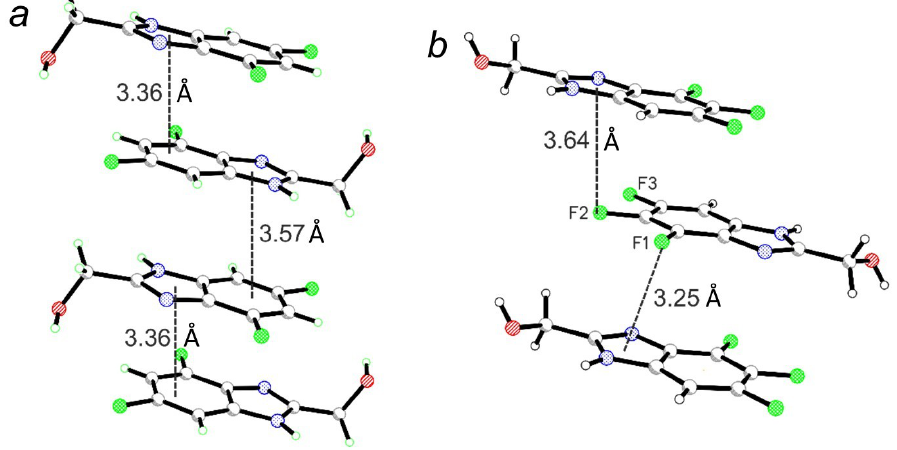
Figure 7. Fragments of crystal structures of 1e ( a ) and 1g ( b ) exemplifying π–π stacking and C–F…π interactions, respectively.